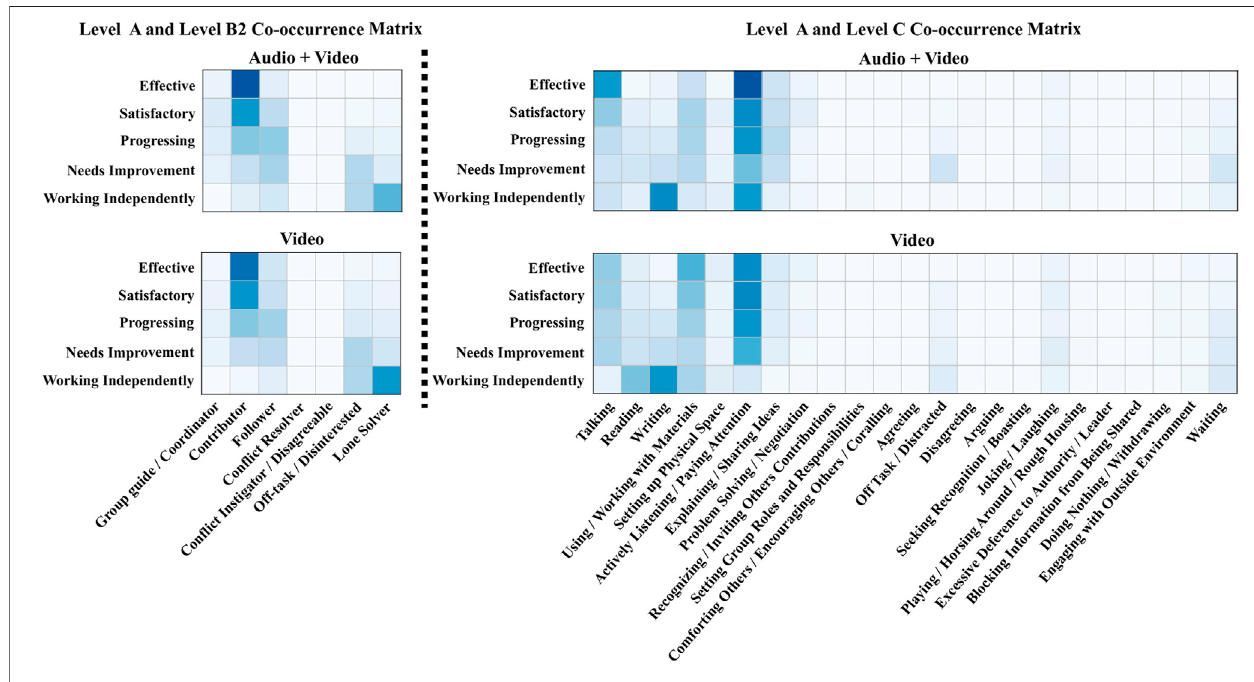
FIGURE 4 | Co-occurrence matrix visualization between Level A and Level B2; Level A and Level C, for the two modality settings.